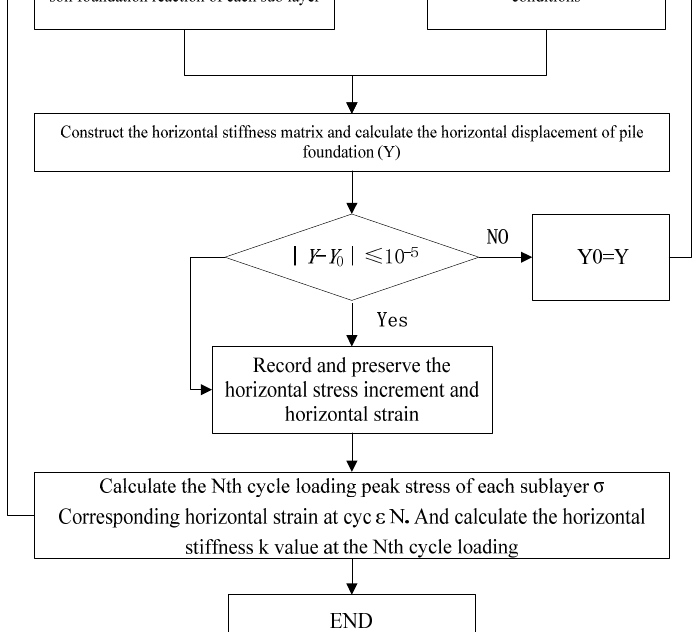
Figure 9. Flow chart for